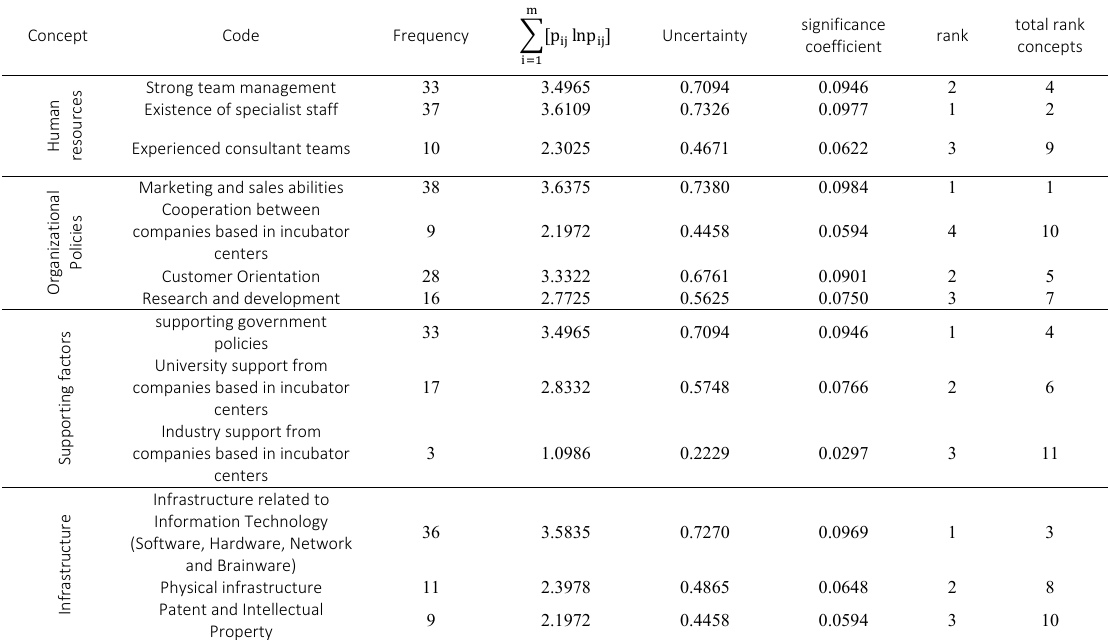
Table 5: Ranking and significance coefficient of the success codes of the companies based in the incubator center Concept